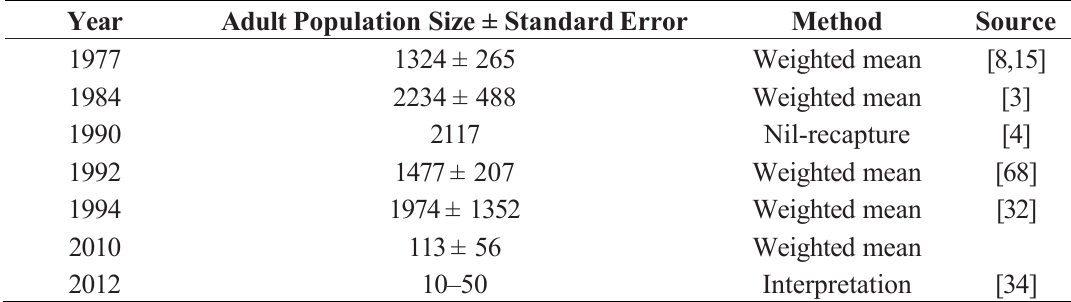
Table A1. Dam Ribeira de Silveirinhos.